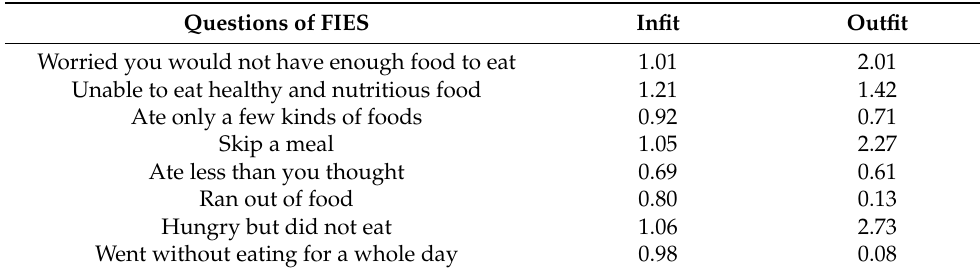
Table 1. Infit and outfit test, measuring the validity of FIES among households with children under 5 years old in Thailand. Questions of FIES Infit